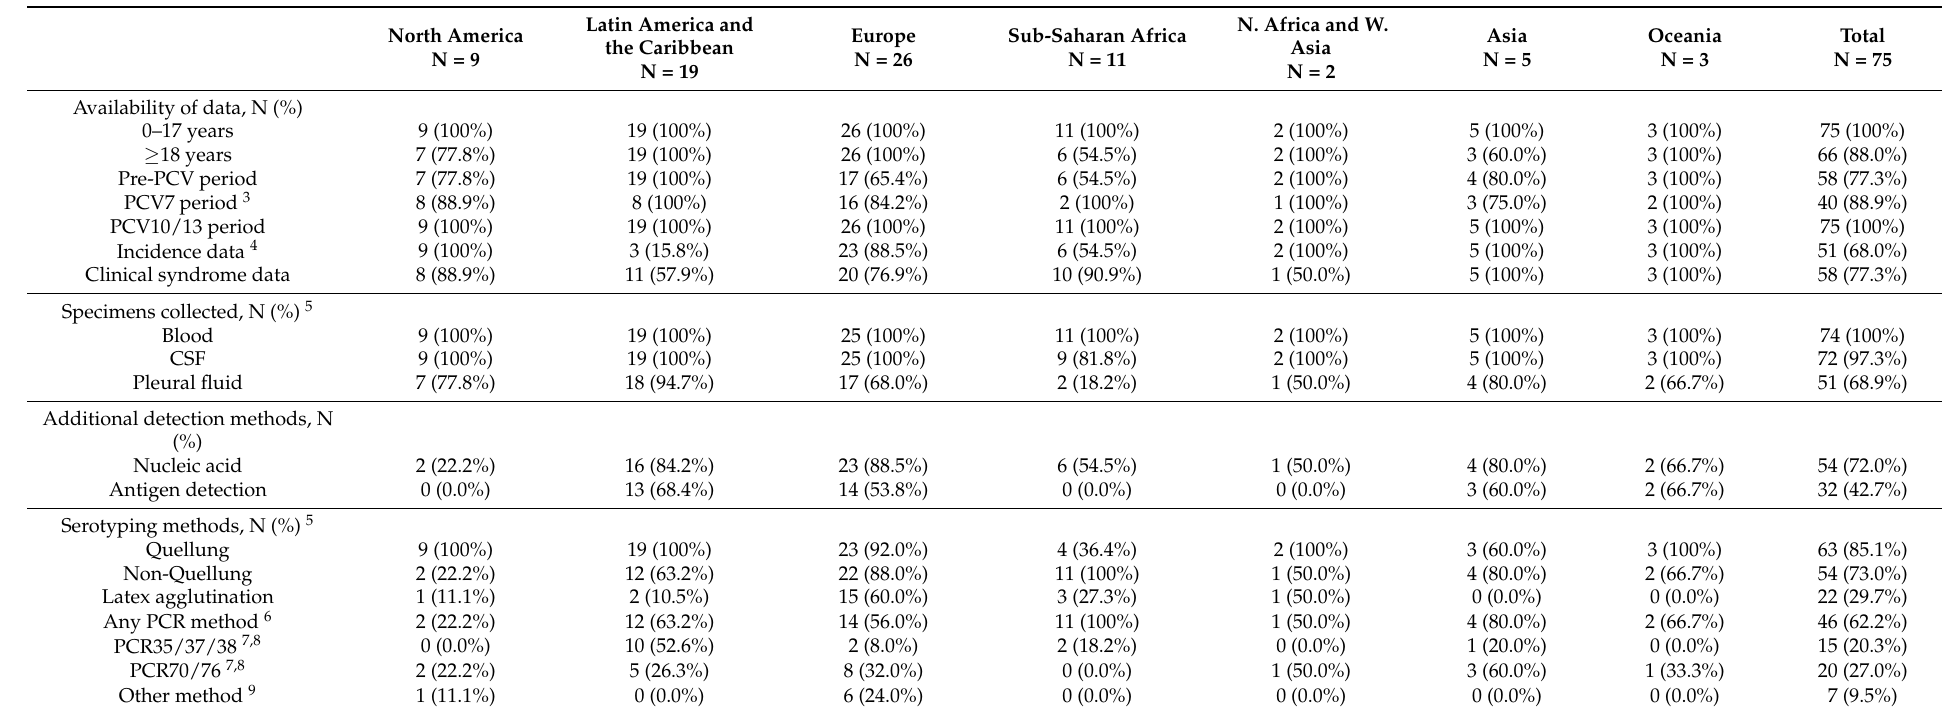
Table 4. Summary of PSERENADE surveillance sites by region